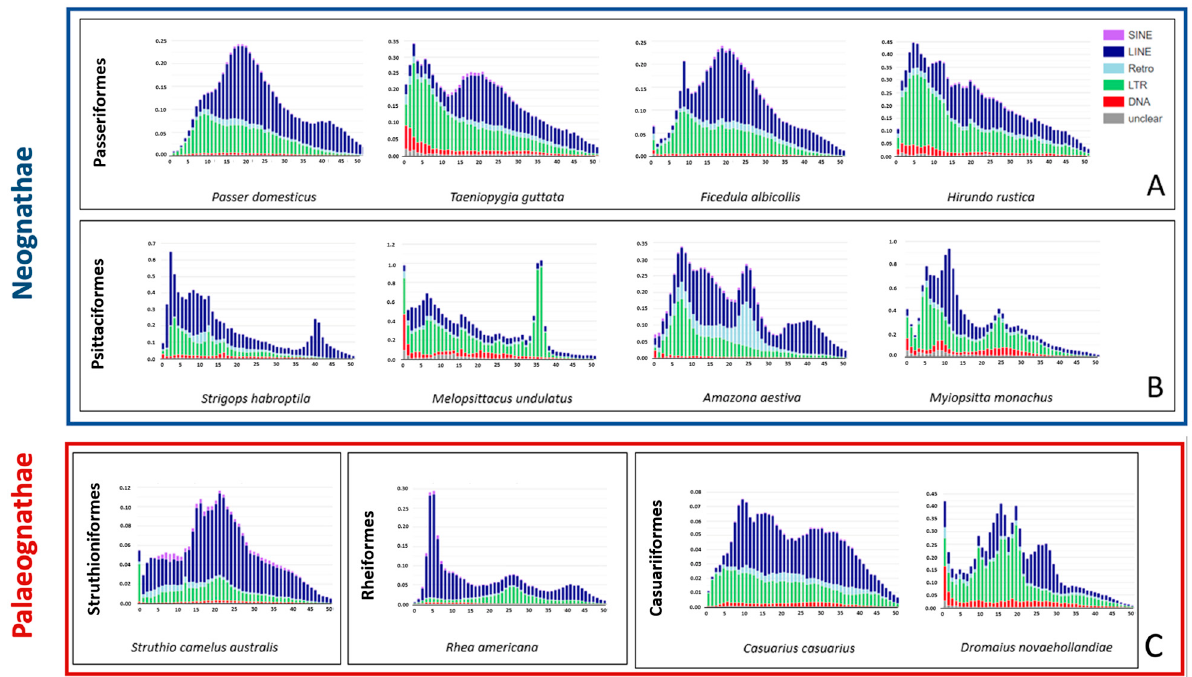
Figure 5. TE landscape plots obtained using Kimura distance-based copy divergence analyses of some species belonging to Neognathae ( blue box ) and Palaeognathae ( red box ). X axis: Kimura substitution level (CpG adjusted); Y axis: percent of genome. Panel ( A ) includes Passeriformes; panel ( B ) includes Psittaciformes; panel ( C ) includes Struthioniformes, Rheiformes, and Casuariformes.